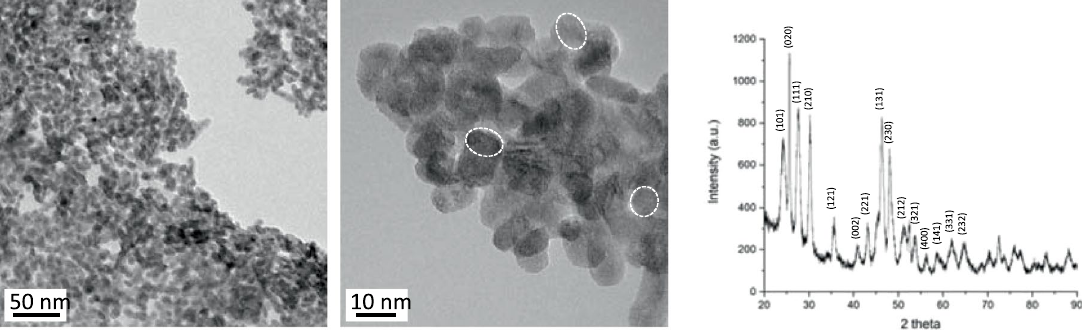
Figure 1. Transmission Electron Microscopy of GdF 3 nanoparticles (left); High resolution of the crystalline nanoparticles (middle) and powder X-Ray Diffraction pattern